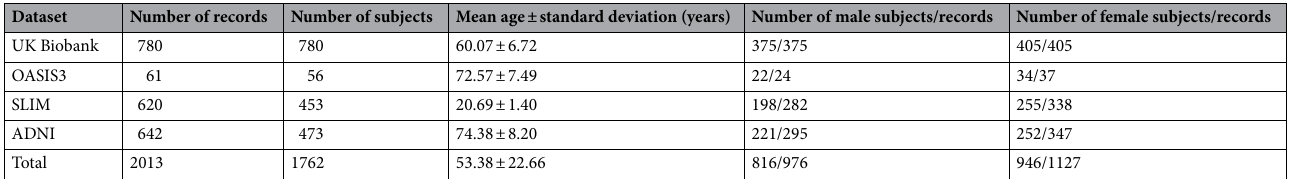
Table 1. Characteristics of the datasets used for the training, validation, and evaluation of the ReSeg brain segmentation pipeline.